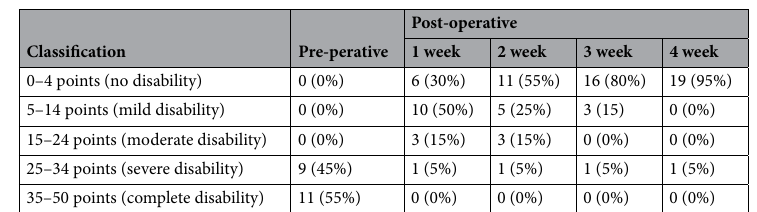
Table 3. Distribution of patients according to NDI scores before and after